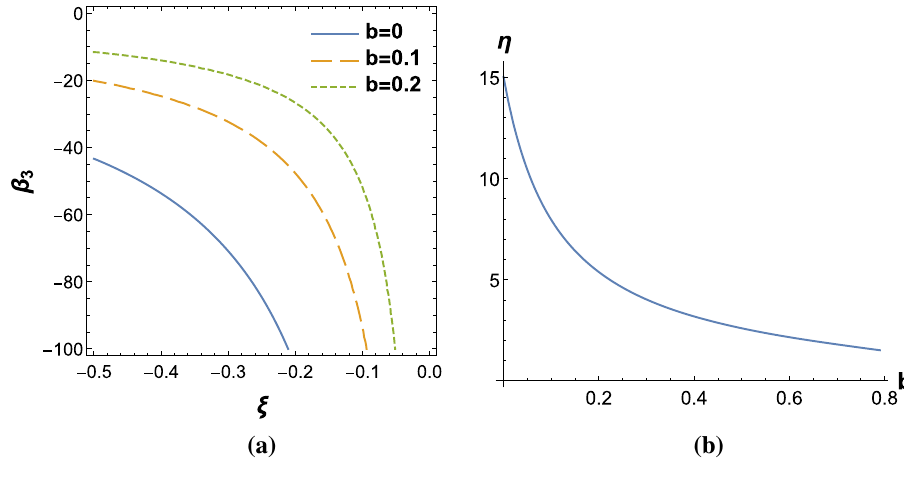
b = 0 . 1, η max = E 3 max / 2 ≈ 7 . 964 at ( s 1 = 0 . 02694 , s 2 = − 0 . 2253 ) ; c when b = 0 . 2, η max = E 3 max / 2 ≈ 5 . 378 at ( s 1 = 0 . 04076 , s 2 = − 0 . 1680 )